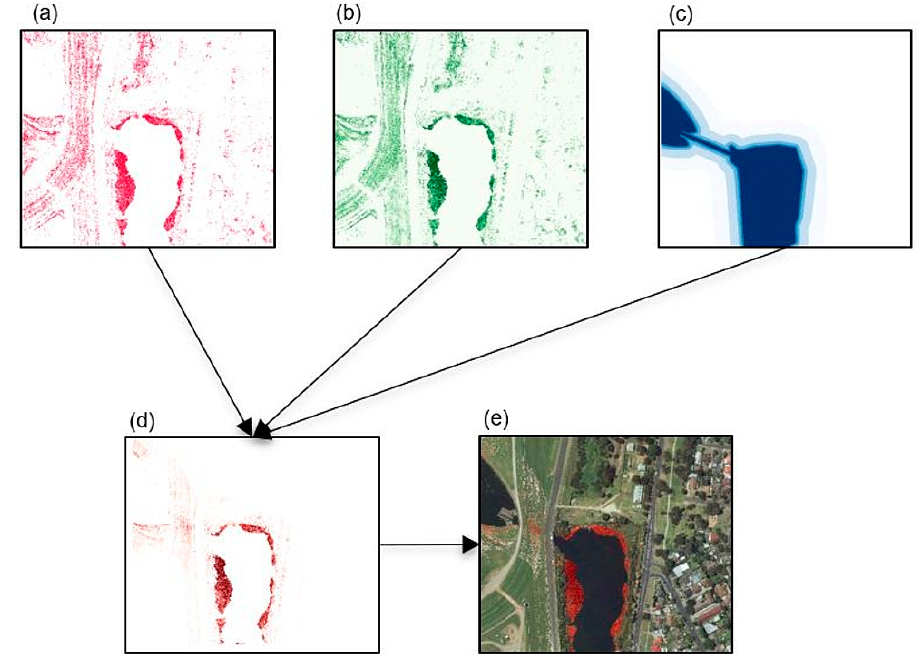
Figure 4. Illustrative workflow used to generate the alligator weed likelihood dataset with examples of ( a ) classified alligator weed raster, ( b ) class probability raster, ( c ) weighted water proximity raster, ( d ) weighted, normalised alligator weed likelihood raster (darker colours indicating a higher normalised probability) and ( e ) an example of the final output overlaid on AP.